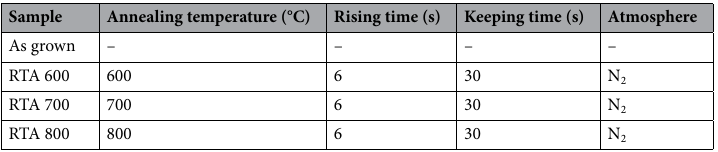
Table 1. The parameters of rapid thermal